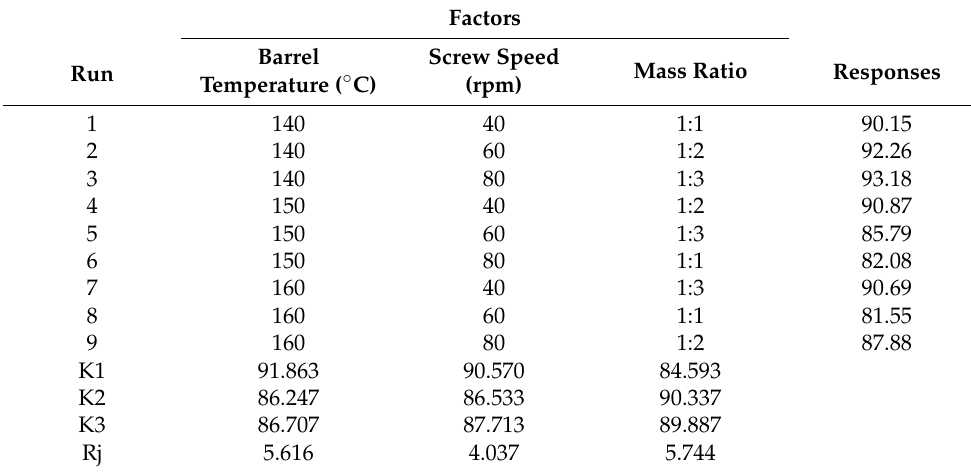
Table 2. Design and results of L9(3)3 orthogonal